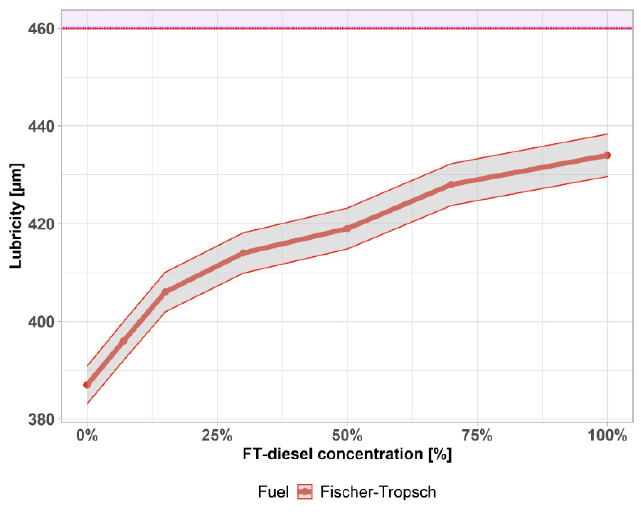
Figure 7. Viscosity of FT − diesel mixtures.